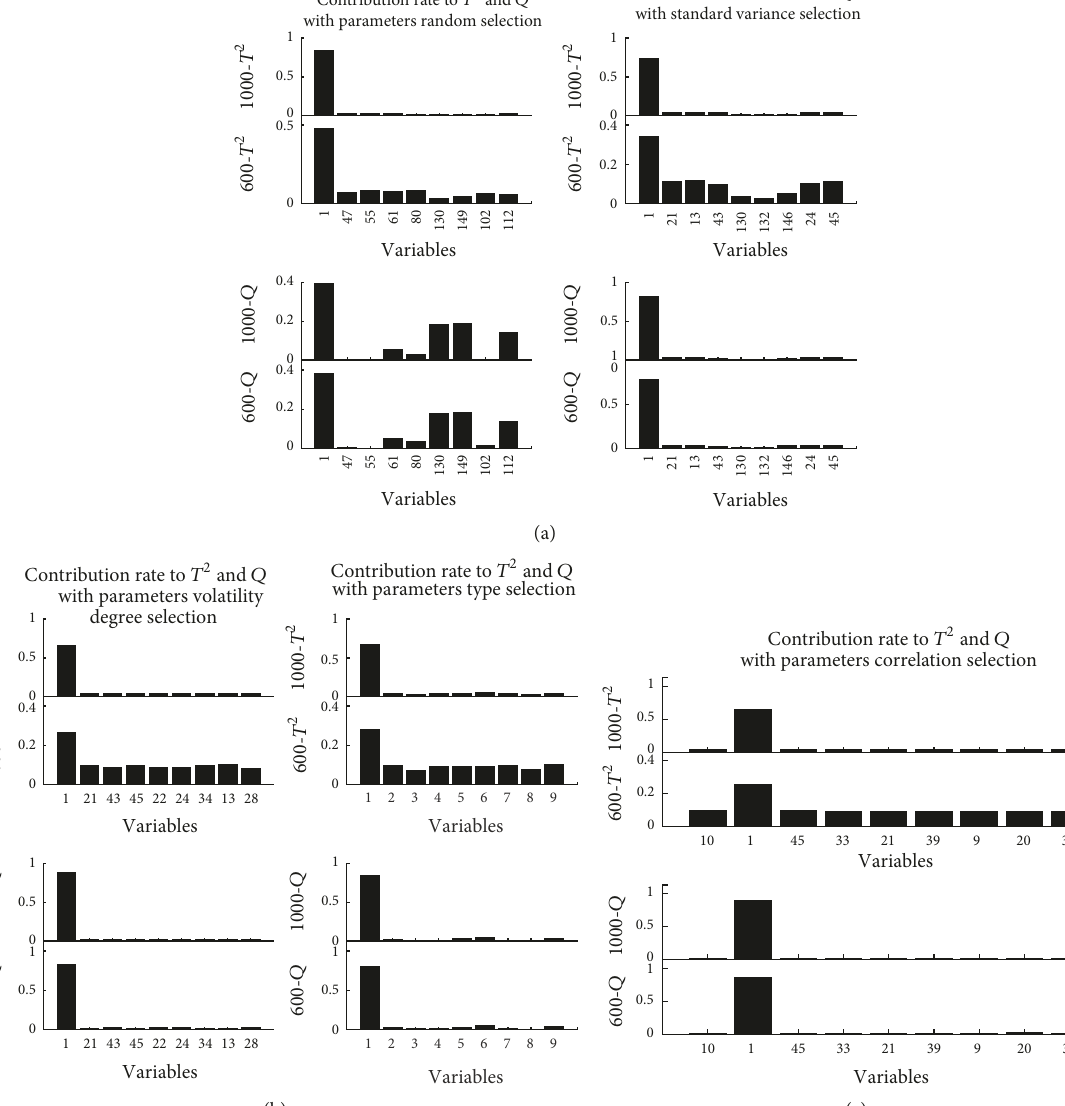
Figure 15: Contributions of sensors to 𝑄 and 𝑇 2 statistics in 5 PCA models with a larger fault on 1# sensor.